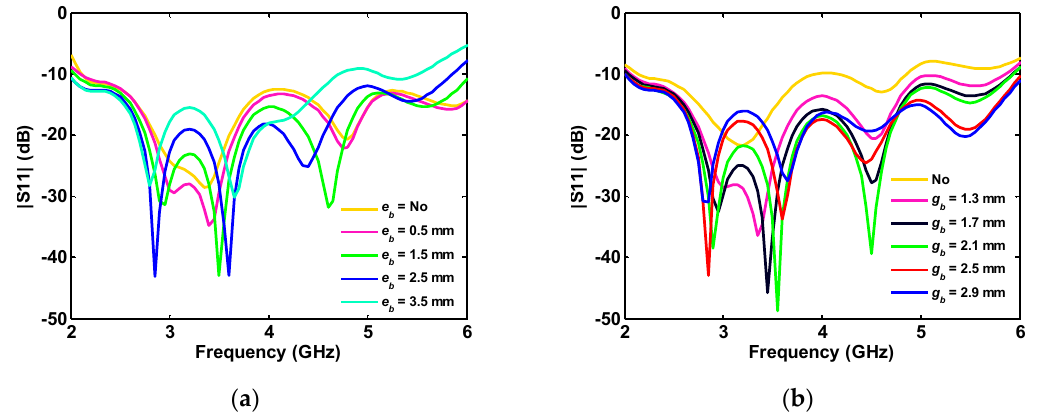
Figure 12. Effect of etched area’s simulated reflection coefficient of four-port antenna: ( a ) disk; and Figure 12. E ff ect of etched area’s simulated reflection coe ffi cient of four-port antenna: ( a ) disk; and ( b ) ( b ) edge of the ground plane. edge of the ground